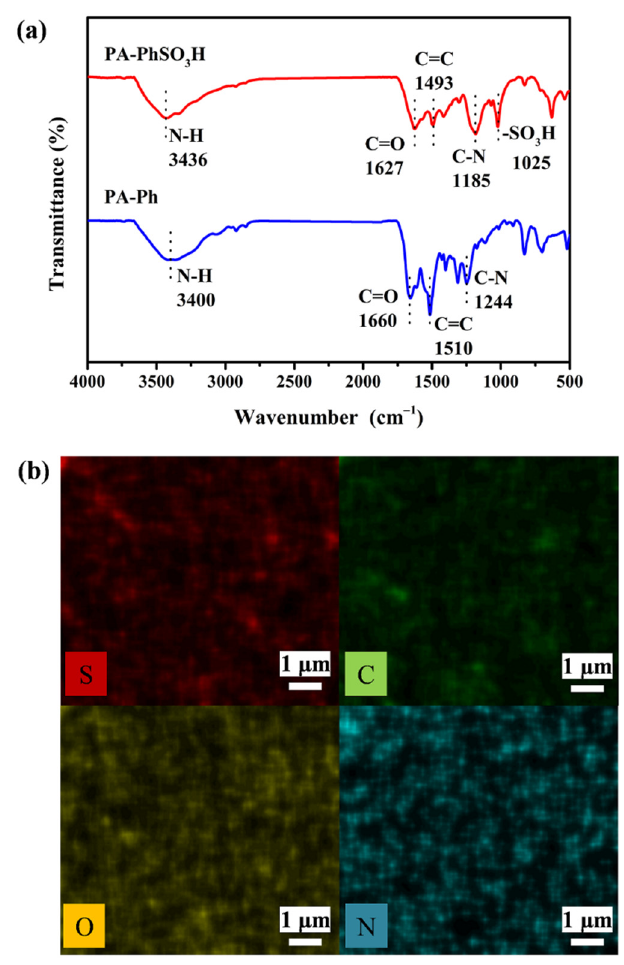
Figure 2. ( a ) FTIR spectra of PA-PhSO 3 H and PA-Ph . ( b ) EDX mapping images of PA-PhSO 3 H .